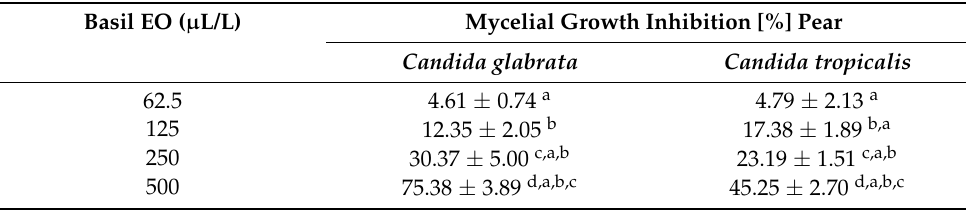
Table 7. In situ analysis of the anti-yeast activity of the vapor phase of OBEO on pears.